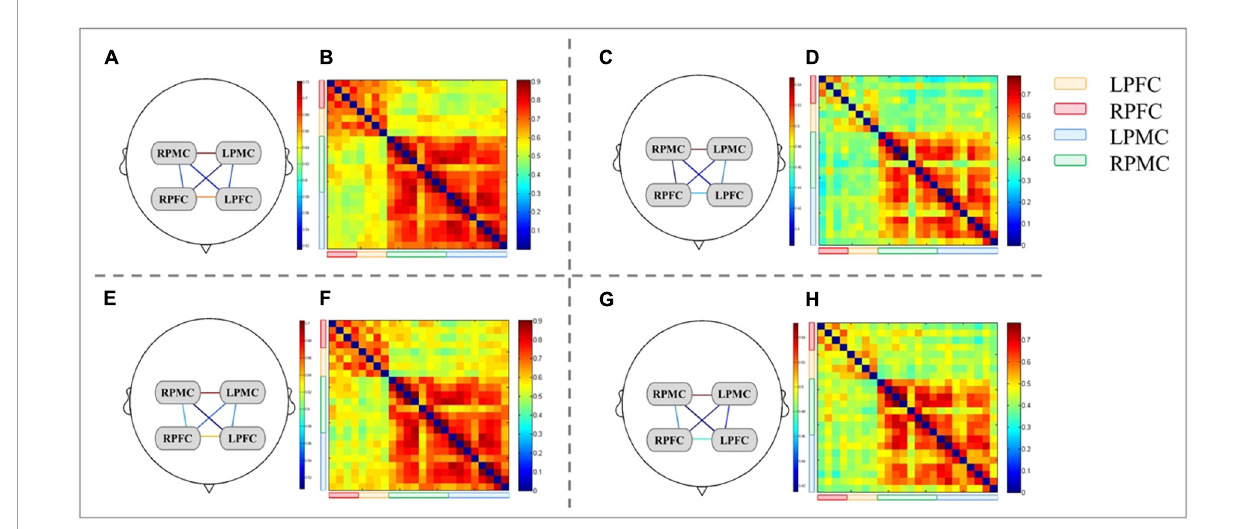
FIGURE6 Brain network and FC matrix of two groups of subjects. (A,B,E,F) are young group, and (C,D,G,H) are elderly group; Panels (A–D) are forward judgment tests; Panels (E–H) are reverse judgment